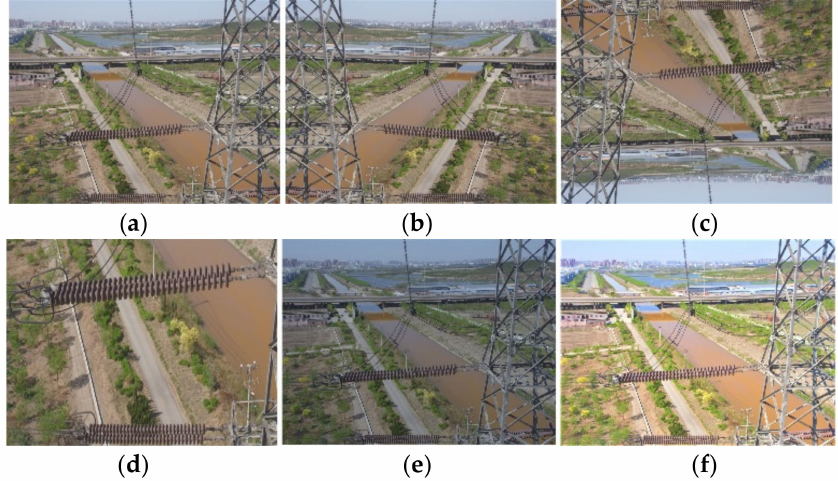
Figure 4. Data augmentation: ( a ) original image, ( b ) mirroring, ( c ) rotation 180 ◦ , ( d ) cropping and scaling, ( e ) adjust contrast, ( f ) adjust